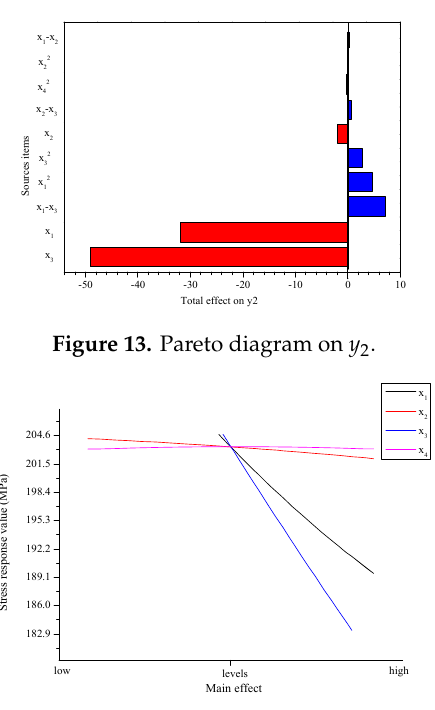
Figure 14. Main effect on y 2 .